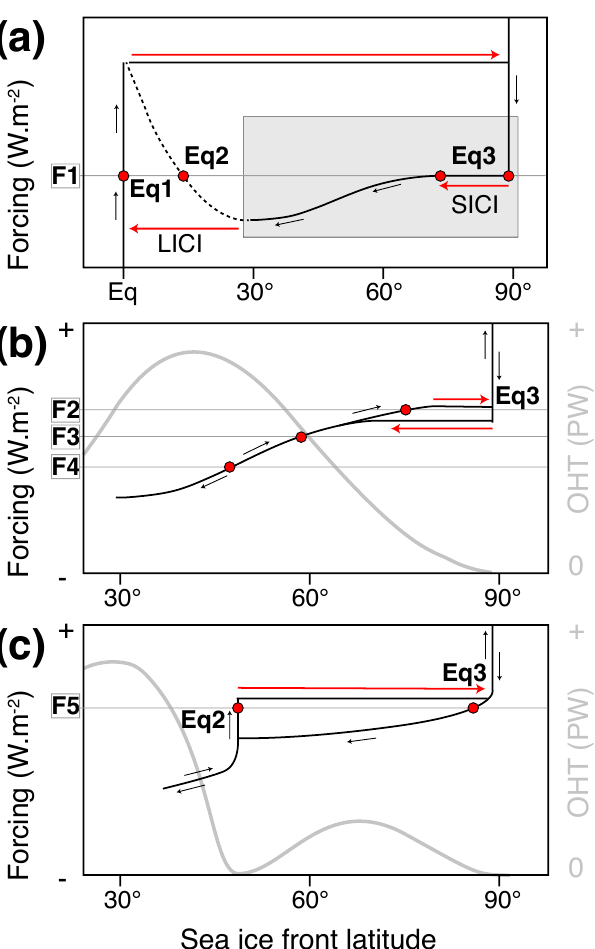
Figure 11. (a) Graph showing the latitude of the sea ice front ( x axis) vs. the climatic forcing ( y axis) for a classical Budyko–Sellers type EBM. Dark arrows indicate the pathway de- scribed by the model through a whole cycle of forcing decrease and increase. Red arrows account for major climatic instabilities. Red circles represent the sea ice edge latitudes corresponding to each analytical solution for a given climatic forcing F1. Dashed lines represent regions that are correct analytical solutions, but are un- able to be realized within the model due to instability. SICI: small ice cap instability; LICI: large ice cap instability. (b) represents the same plot as (a) , while focusing on the domain shaded in grey in (a) . The forcing is decreased and then increased without reaching the snowball equilibrium Eq1. Several forcing values (F2, F3 and F4) are represented, each one leading to a single sea ice cap of fi- nite size (red circles). The OHT pattern corresponding to the purely diffusive transport characteristic of classical EBMs is overlayed in grey (right y axis). (c) Same plot as (b) for the extended EBM from Rose and Marshall (2009) (see the main text for explanations) in which the OHT pattern is modified (grey curve). Note the two sea ice caps of finite size corresponding to the forcing level F5. (a) is adapted from North et al. (1981), (b) and (c) are modified after Rose and Marshall (2009).